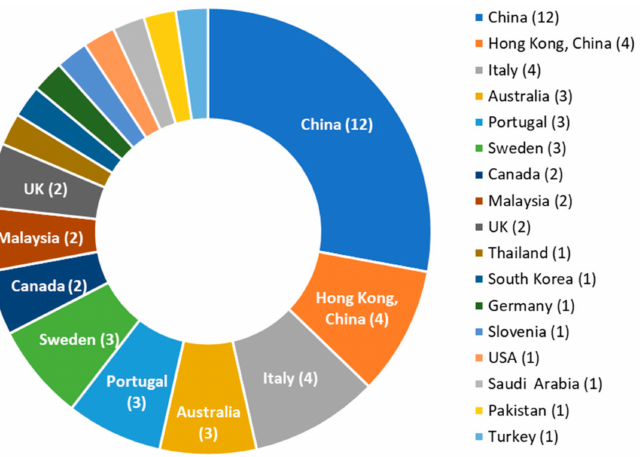
Figure 4. Geographic distribution of the research locations of reviewed